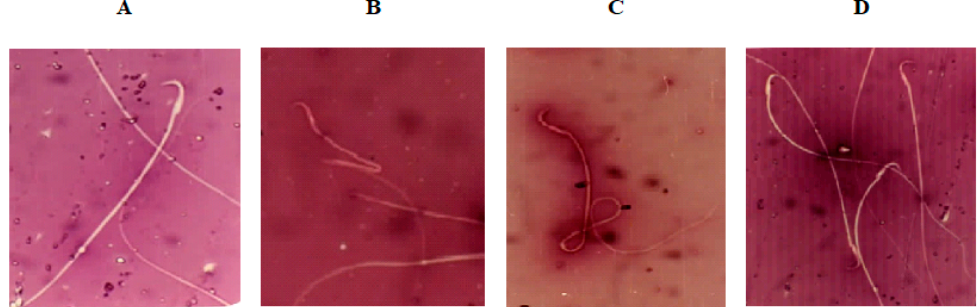
Figure 2. Photomicrographs (400 × ) of ( A ) normal sperm morphology of normal control (NC) rats; ( B , C ) sperm with bent midpiece and headless sperm, and sperm with coiled tail of diabetic control (DC) rats, respectively; and ( D ) normal sperm morphology of diabetic rats exposed to Momordica charantia at 500 mg / mg b.w.(D + MC-500 group).